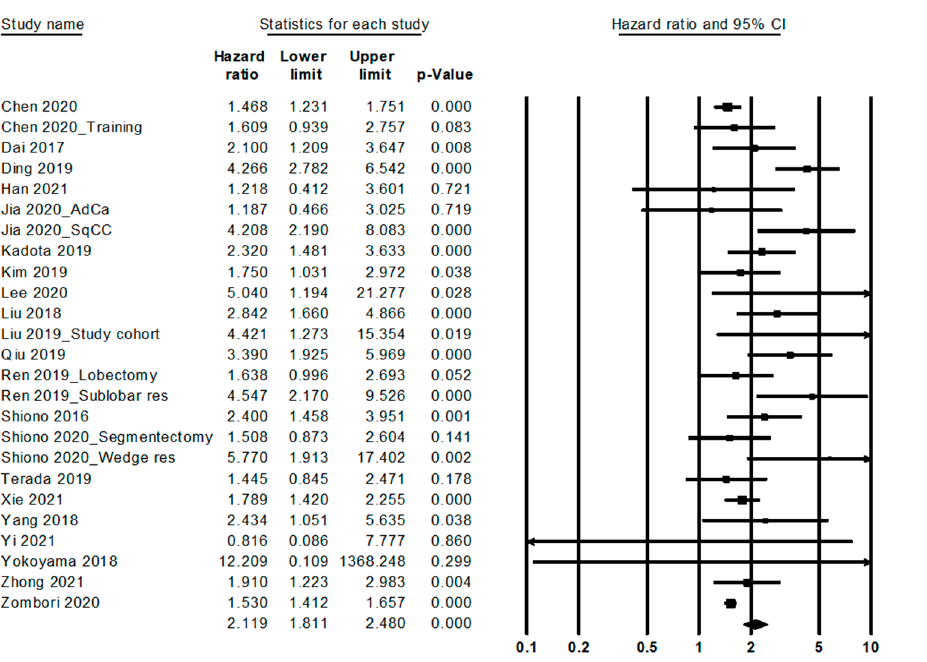
Figure 2. Forest plots for the overall survival.